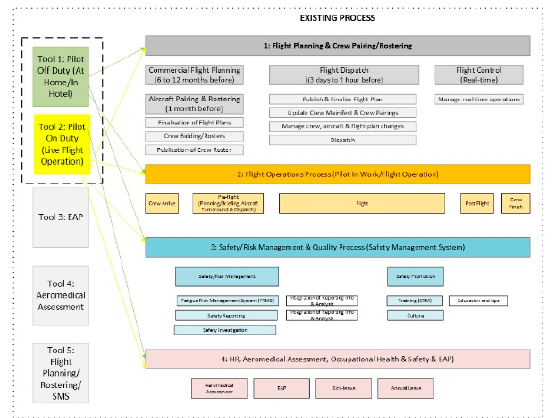
Figure A3. As Is Process.